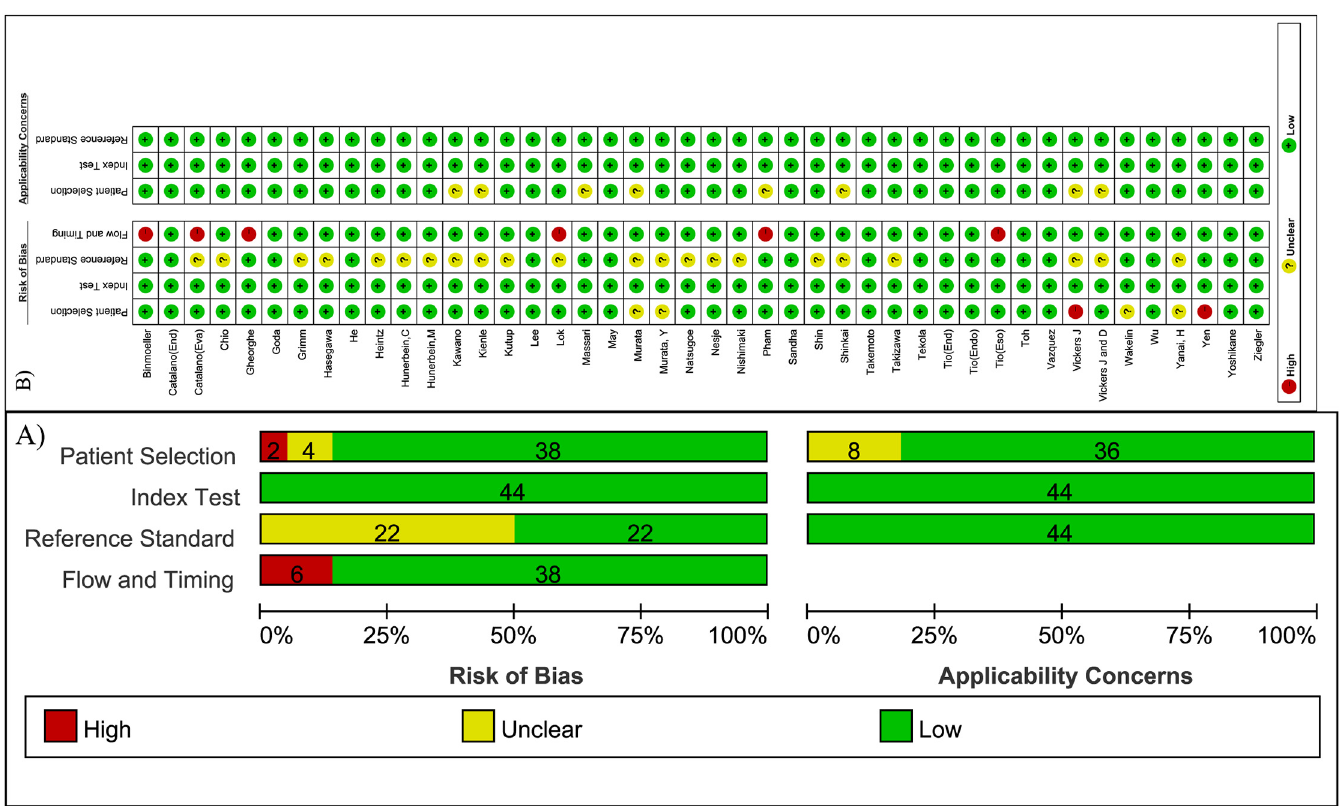
Fig 2. Methodological quality of included studies. A) Methodological quality graph, B) Methodological quality summary.